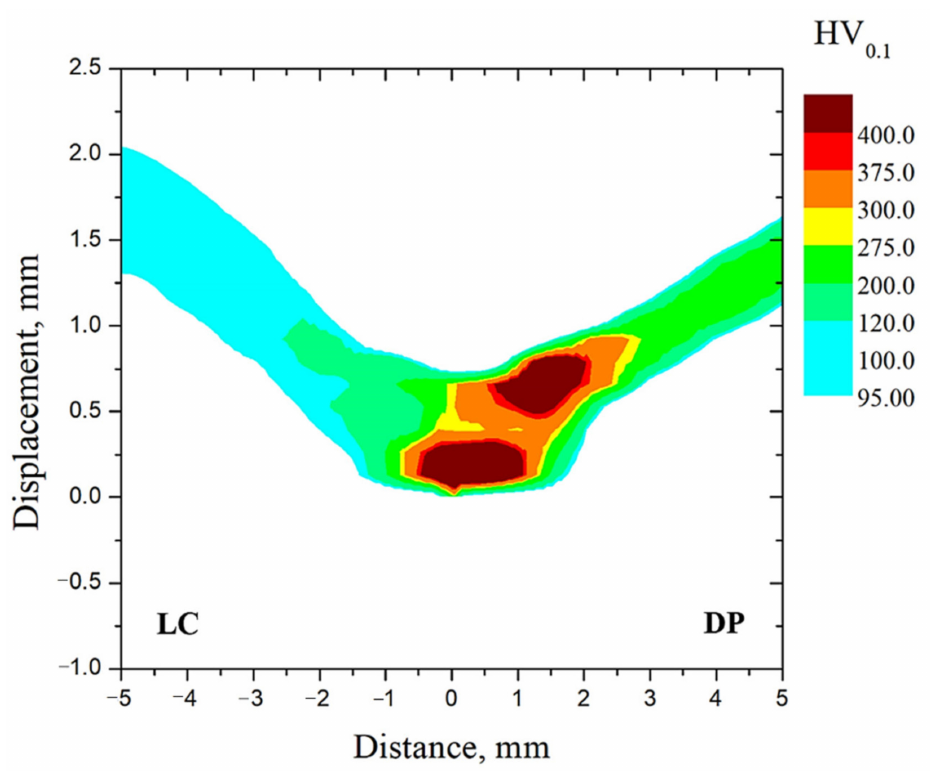
Figure 17. Hardness distribution after impact test in dissimilar welding LC–DP. Figure 18 presents the strain vs. time behavior of dissimilar welding. It is possible to identify a maximum microstrain of 22.4 at 2.24 ms.—time correlation was realized by means of Equation (2). Maximum reaction force is 34.49 kN at 2.42 s (Figure 18).